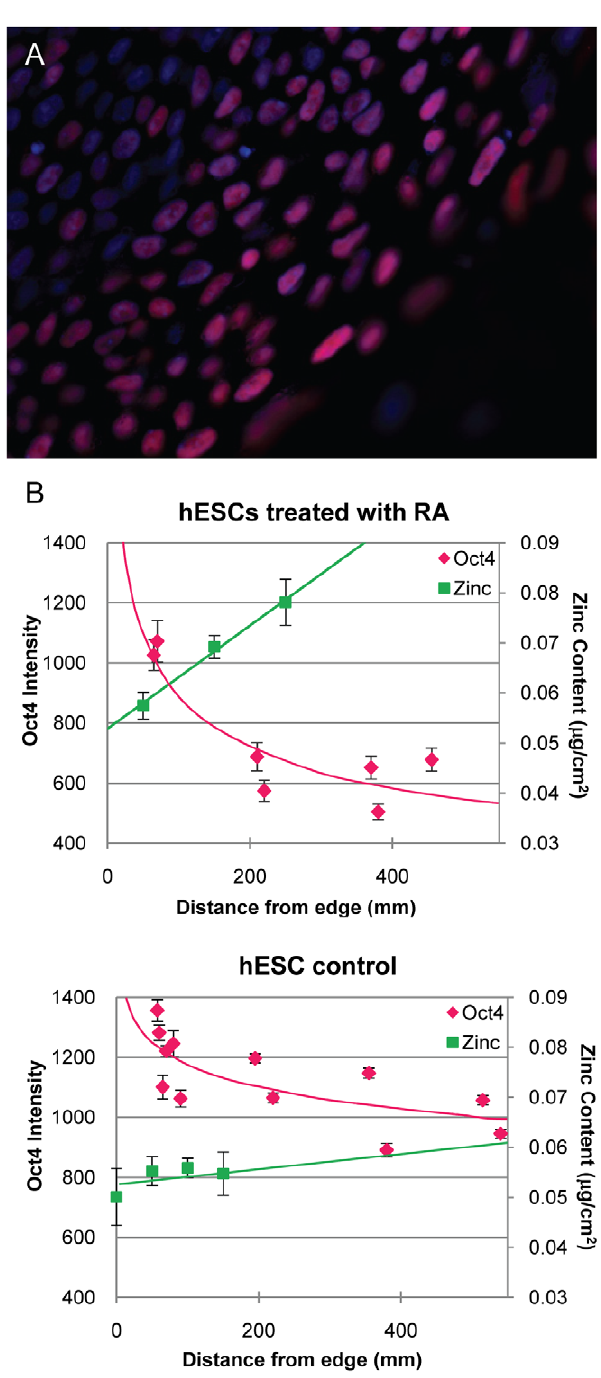
(pink) lost at center of hESC colonies treated with RA. Cells are counterstained with Hoechst (blue). B. Graphs depict quantified Oct4 intensity vs. total zinc content from XRF of control (i) and RA treated (ii) hESCs across a typical colony. Results are plotted as mean 6 SEM.